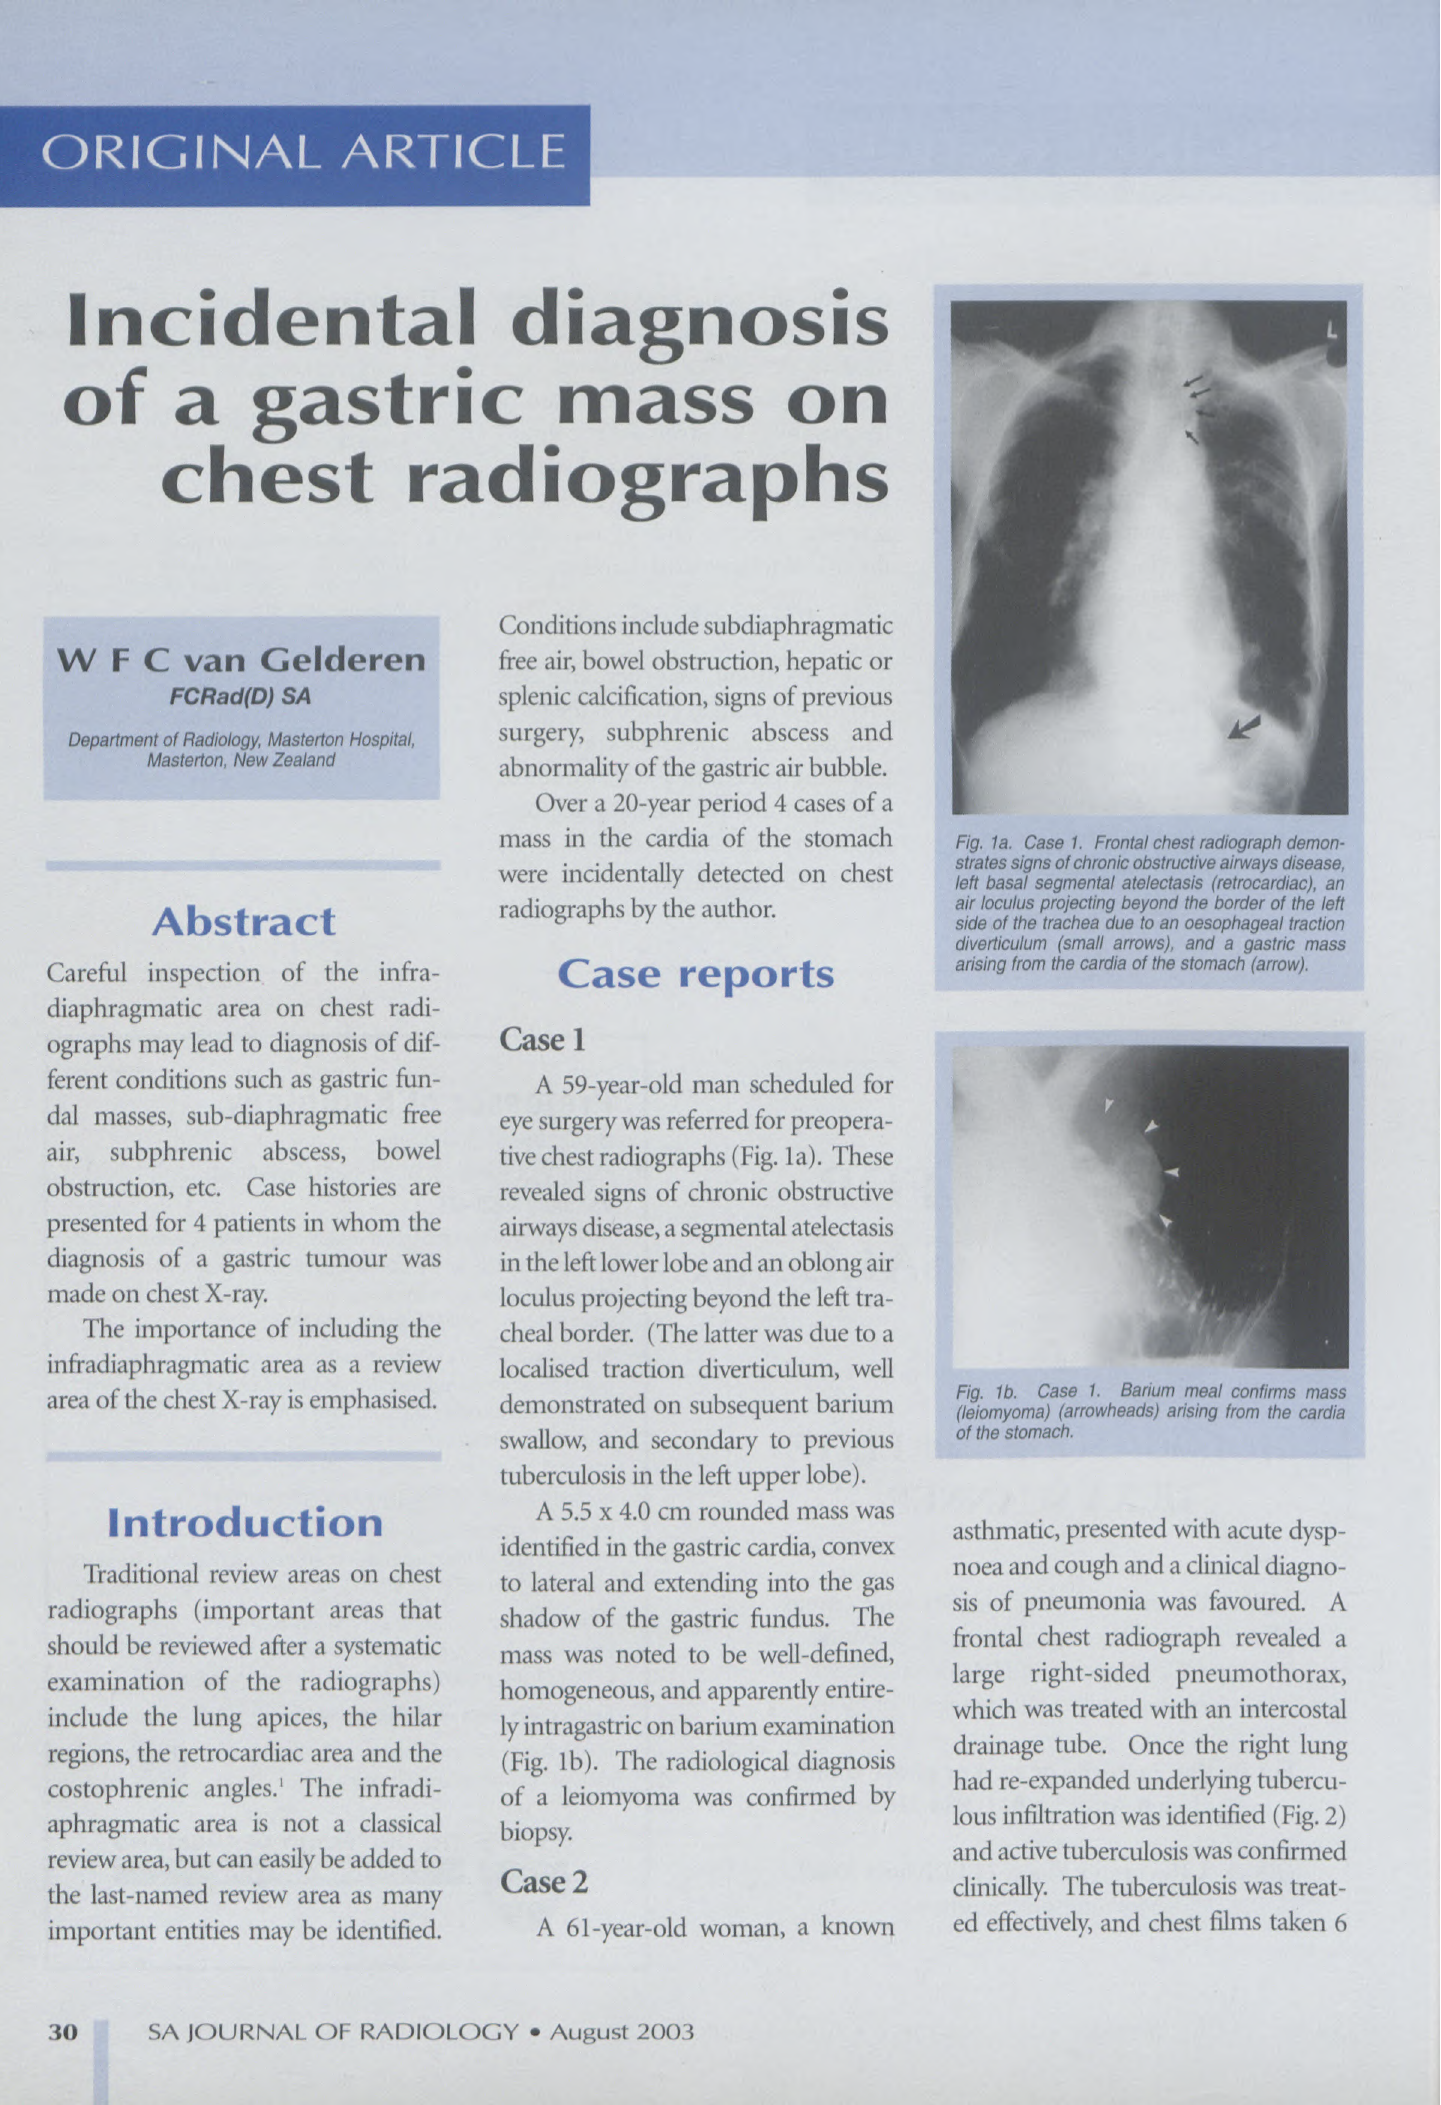
Fig. 1a. Case 1. Frontal chest radiograph demon- strates signs of chronic obstructive airways disease, left basal segmental atelectasis (retrocardiac), an air loculus projecting beyond the border of the left side of the trachea due to an oesophageal traction diverticulum (small arrows). and a gastric mass arising from the cardia of the stomach (arrow).